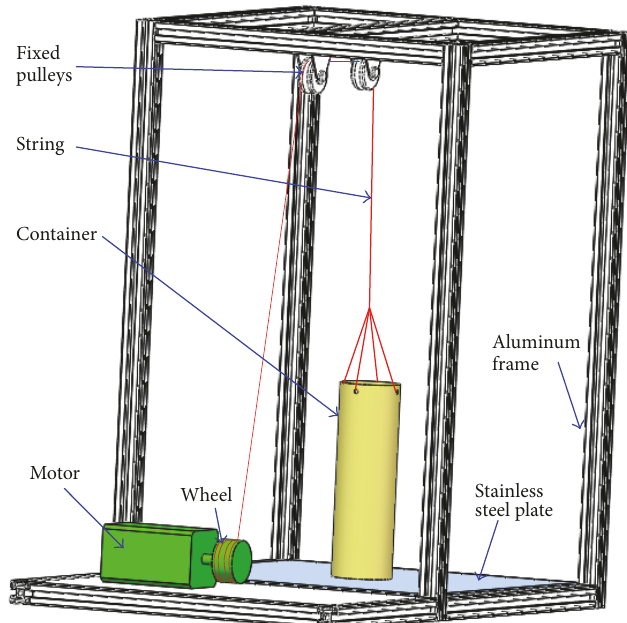
Figure 1: Sketch of the experimental setup used in this research.